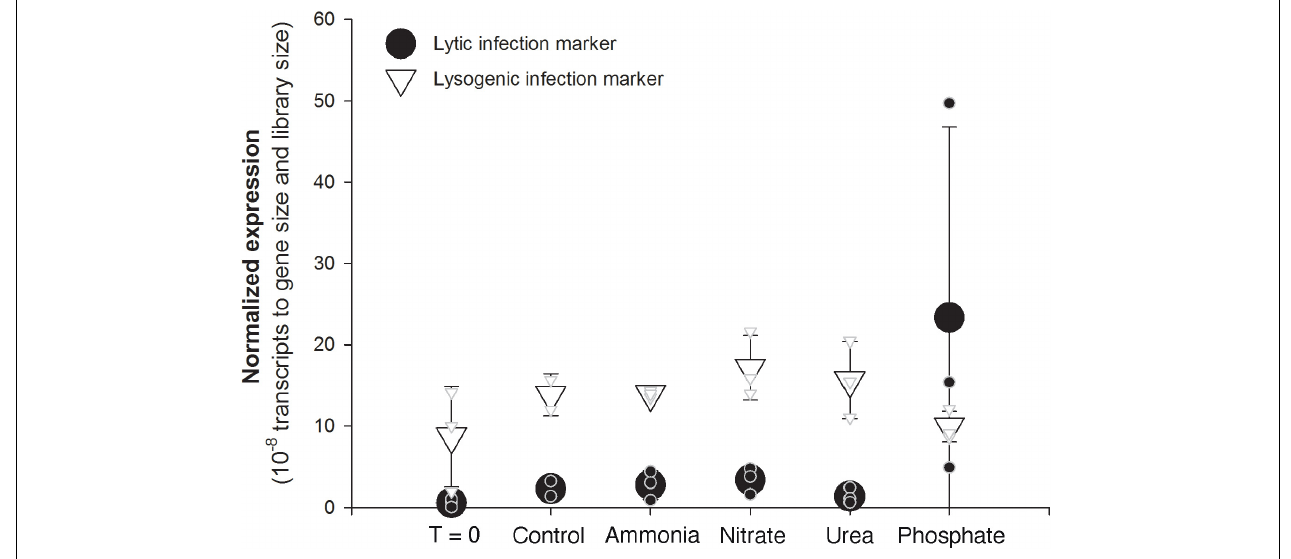
FIGURE 4 | Average (large symbols) and individual bottle (small symbols) normalized expression of a Microcystis phage marker of lytic activity (gp91 tail sheath, black circles) and a marker of lysogenic activity (gp136 recombinase/integrase, open triangles). Expression was normalized to both library size of each sample and the length of each